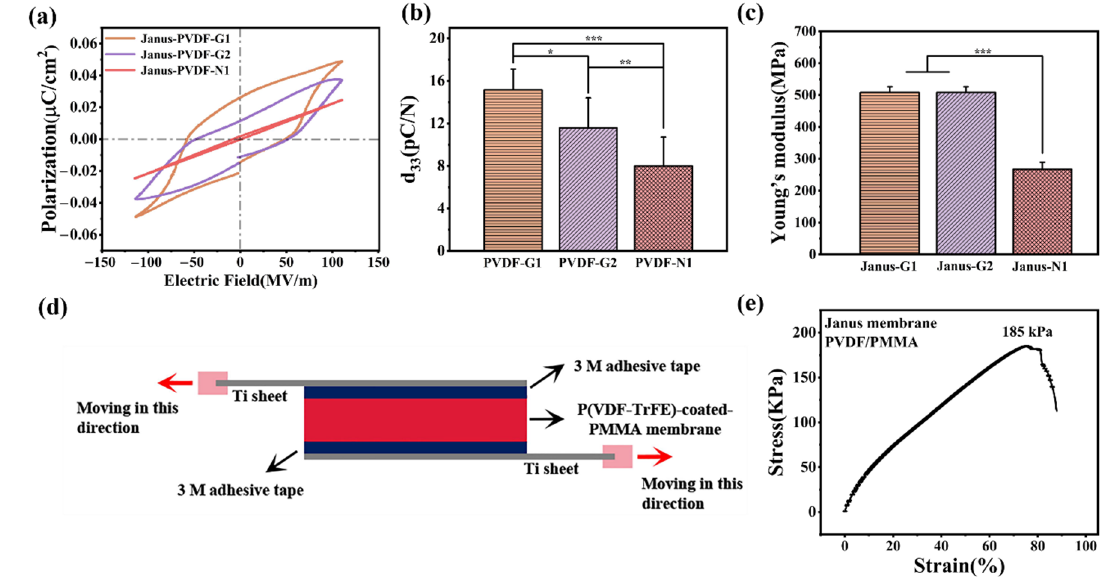
Figure 2. ( a ) Ferroelectric hysteresis loops of P(VDF-TrFE) coatings. ( b ) Piezoelectric coefficients (d 33 ) of P(VDF-TrFE) coatings. ( c ) Spring constant of Janus membranes in the vertical direction. ( d ) Schematic diagram of shear bonding strength characterization. ( e ) Shear bonding strength of P(VDF-TrFE) coating and PMMA film (* p < 0.05, ** p < 0.01, *** p < 0.001).